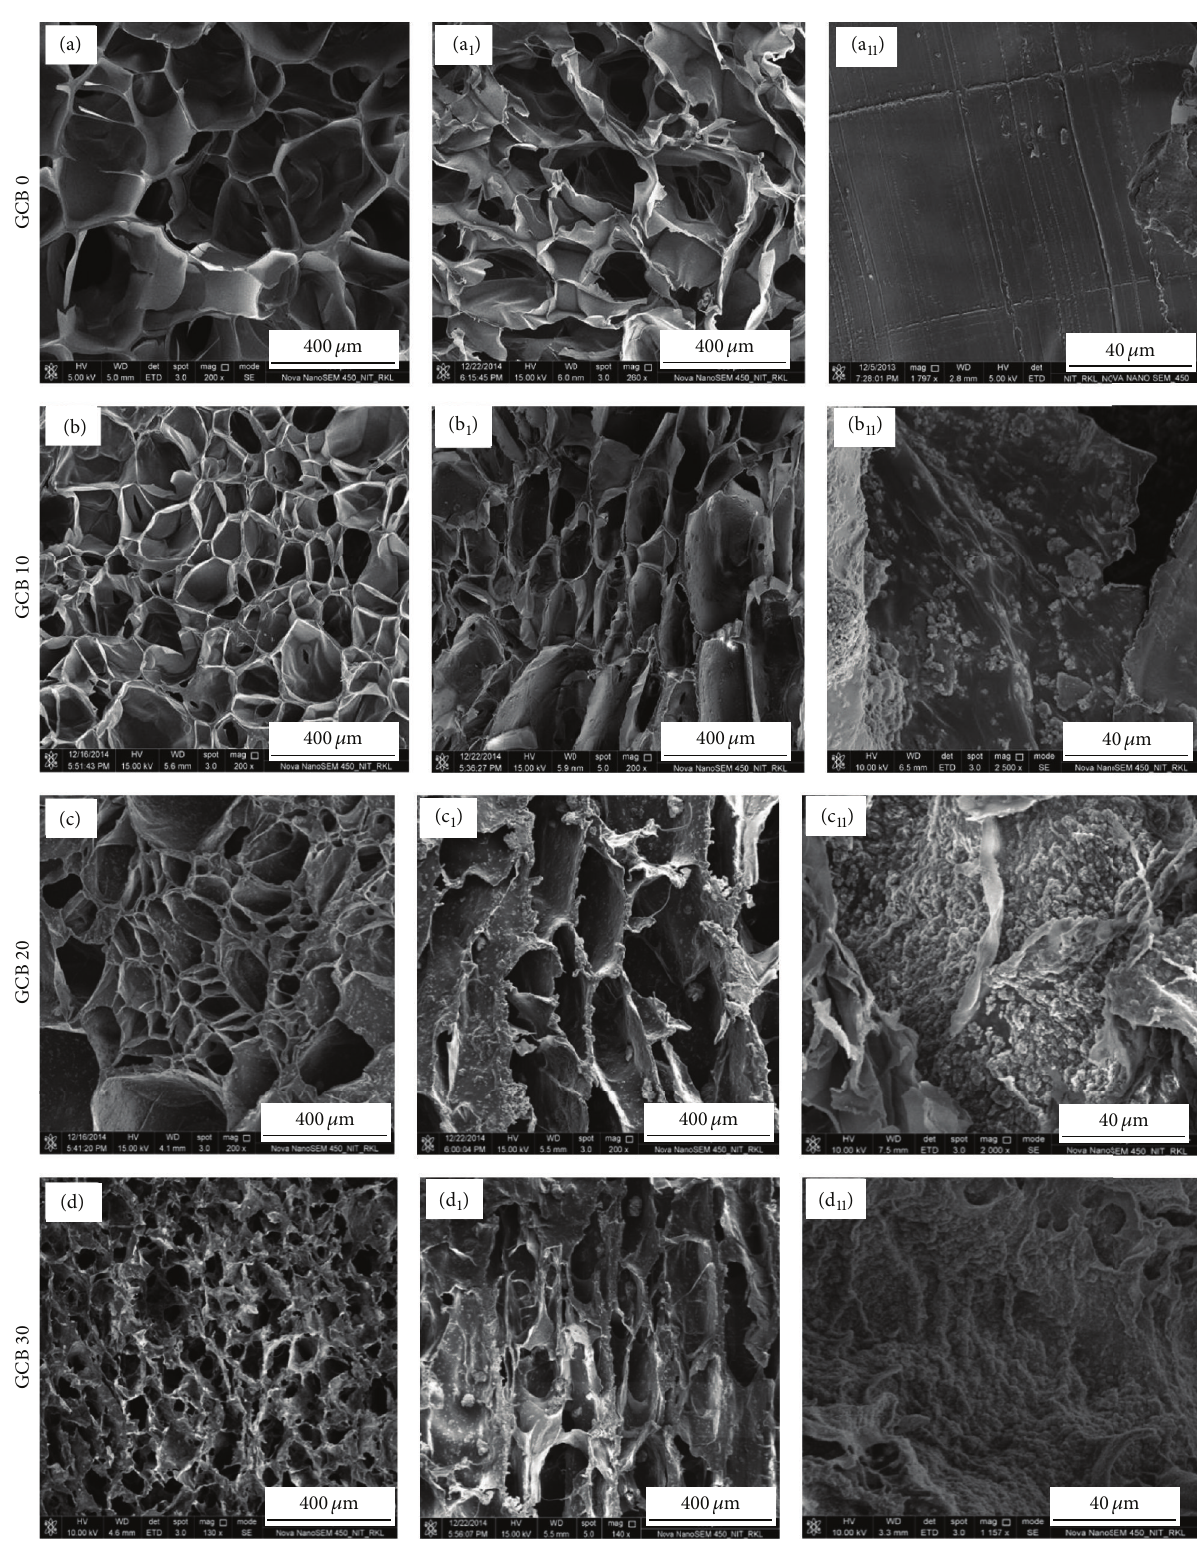
Figure 7: FESEM microstructure of composite scaffolds. Cross-sectional Figures 7((a)–(d)), longitudinal Figures 7((a 1 )–(d 1 )), and pore wall distribution Figures 7((a 11 )–(d 11